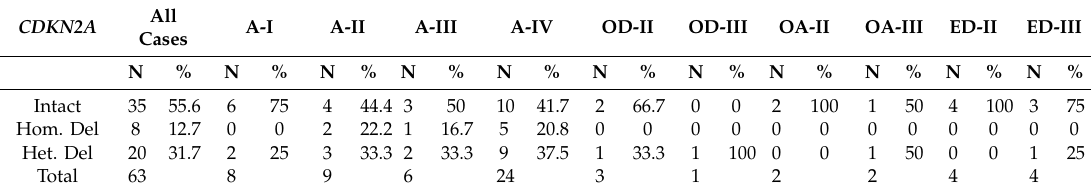
Table 5. Frequency of CDKN2A deletion in each histologic and WHO grading group.